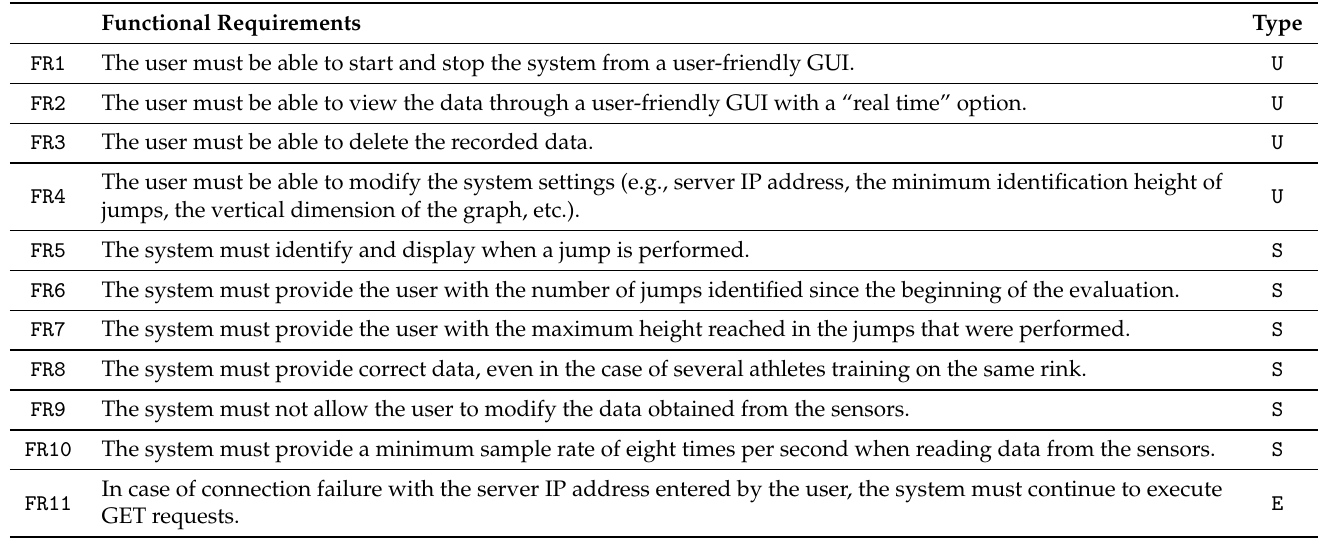
Table 1. The functional requirements.